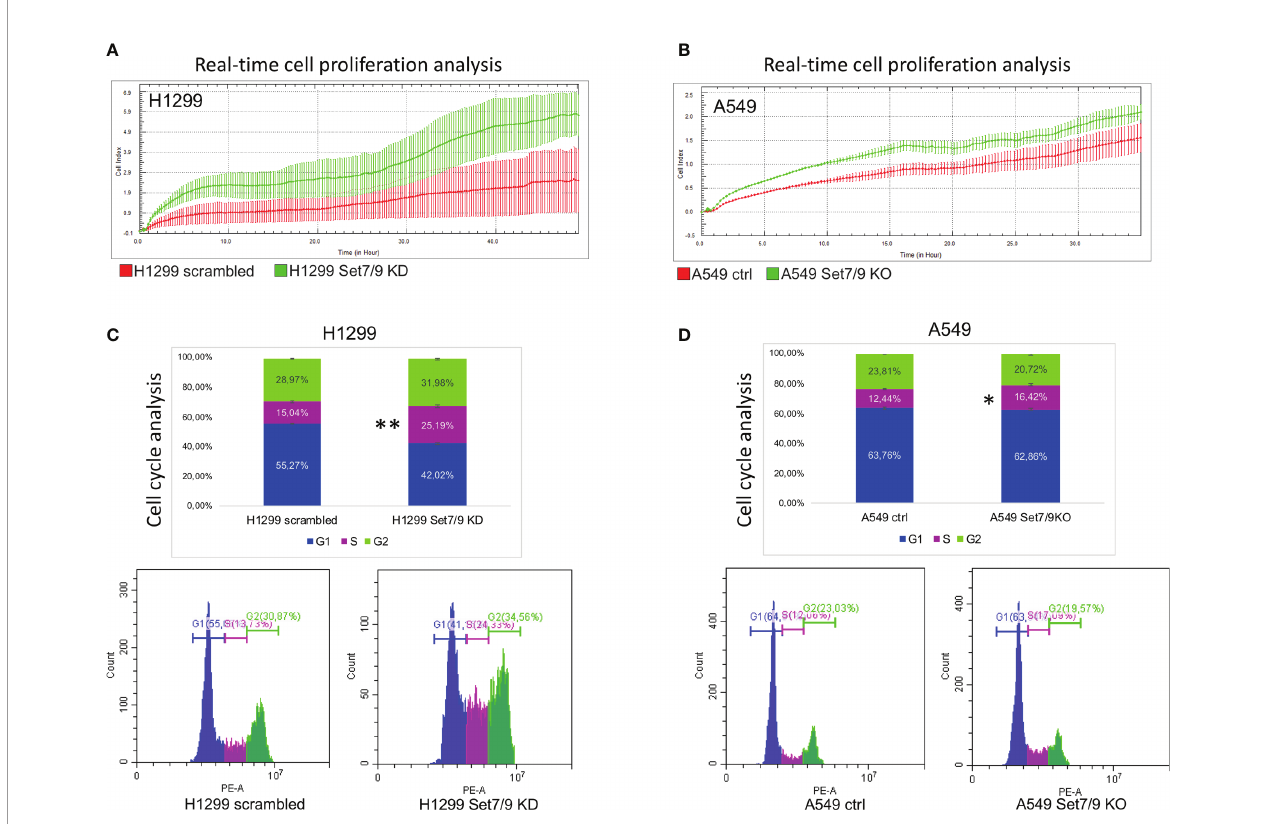
FIGURE 5 | The effect of Set7/9 downregulation on the proliferation and cell cycle of NSCLC cell lines H1299 and A549. (A, B) The analysis of cell proliferation in real time, using the xCelligence system, of NSCLC cell lines (A) H1299 and (B) A549 with Set7/9 knockdown (Set7/9 KD) and knockout (Set7/9 KO), compared to control (scrambled or vector) cells. (C, D) The analysis of the cell cycle phases ’ distribution of NSCLC cell lines (C) H1299 and (D) A549 with Set7/9 knockdown (Set7/9 KD) and knockout (Set7/9 KO) compared to control (scrambled or vector) cells. *p < 0.05; **p <